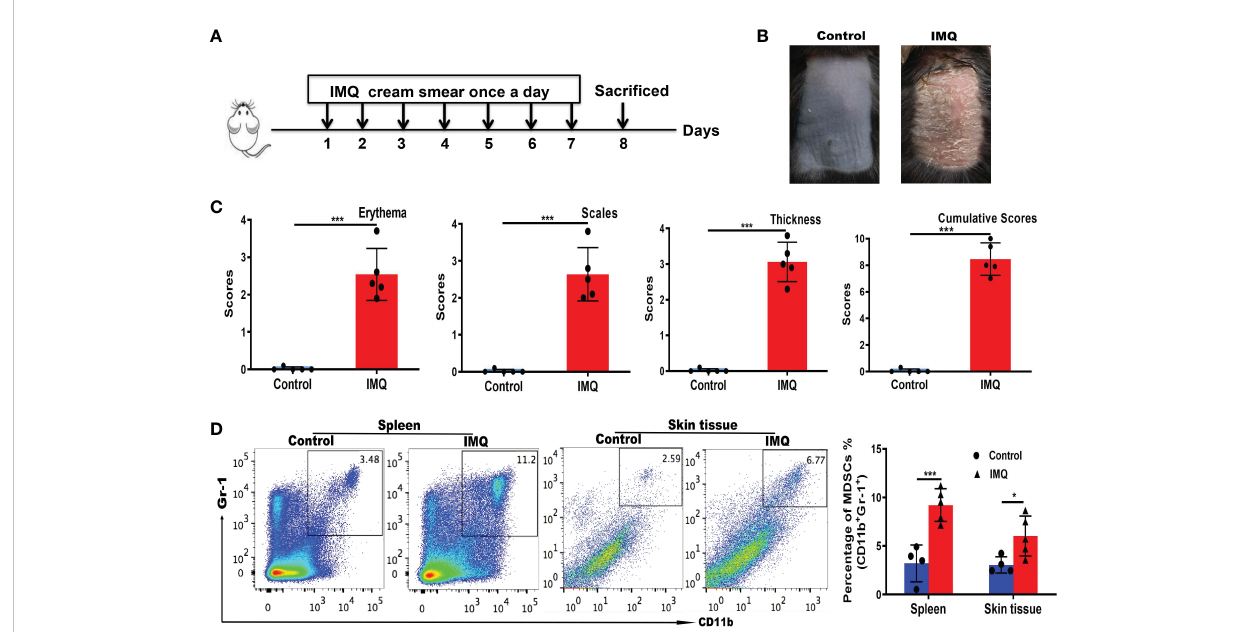
FIGURE 3 MDSC populations increased in mice with IMQ-induced psoriasis. (A) Experimental procedures and establishment of an IMQ-induced psoriasis mouse model. (B) Murine back skin specimens. (C) PASI scoring of erythema, scaling, and thickness, and the cumulative scores for different groups. (D) Detection of MDSCs in the spleen and skin by fl ow cytometry and subsequent quanti fi cation. *P < 0.05, ***P < 0.001. IMQ, imiquimod; MDSC, myeloid-derived suppressor cell; PASI, Psoriasis Area and Severity